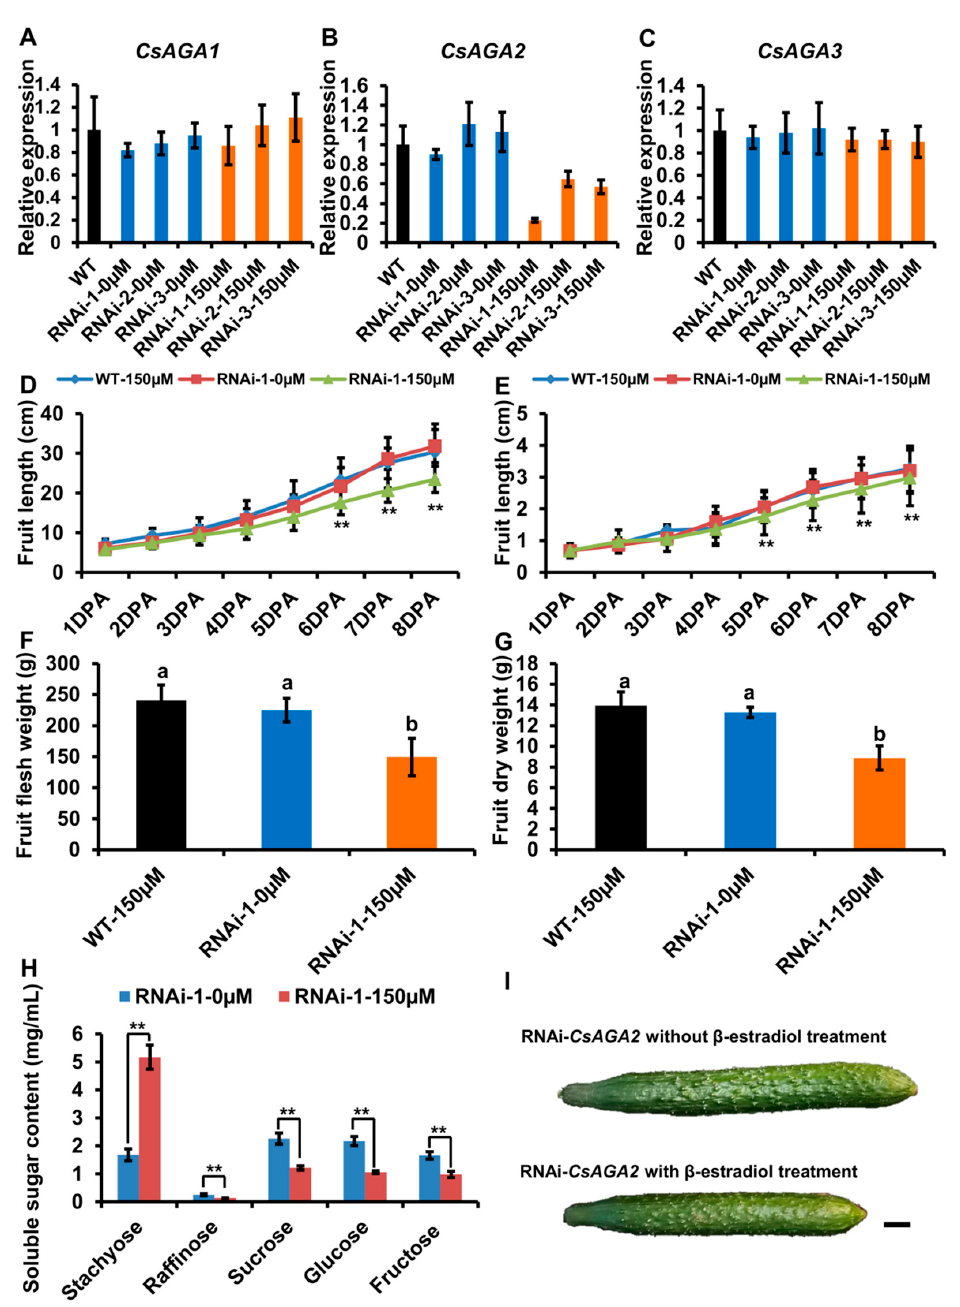
Figure 4. CsAGA2 mainly regulated stachyose hydrolysis but not Raf. ( A – C ) qRT-PCR analysis of the expression of CsAGA1 ( A ), CsAGA2 ( B ) and CsAGA3 ( C ) in RNAi- CsAGA2 plants with or without β -estradiol treatment. The expression of CsAGA2, but not CsAGA1 ( A ) and CsAGA3 ( C ), was down regulated in RNAi- CsAGA2 plants with 150 µ M β -estradiol treatment but not regulated in RNAi- CsAGA2 plants without β -estradiol treatment ( B ). Three lines of RNAi- CsAGA2 were chosen for qRT-PCR analysis. The bars represent standard deviation (SD) of three biological replicates. 18S rRNA act as reference gene and relative amounts were normalized with respect to the expression in WT. ( D , E,I ) The fruit length ( D,I ) and fruit diameter ( E,I ) were decreased in RNAi- CsAGA2 plants treated with β -estradiol compared with WT with β -estradiol treatment and RNAi- CsAGA2 plants without β -estradiol treatment. The fruits at 1DPA (day post-anthesis), 2DPA, 3DPA, 4DPA, 5DPA, 6DPA, 7DPA and 8DPA stages were selected for measurement. The bars represent standard deviation (SD) of fifteen biological replicates. ( F , G ) The fruit fresh weight ( F )